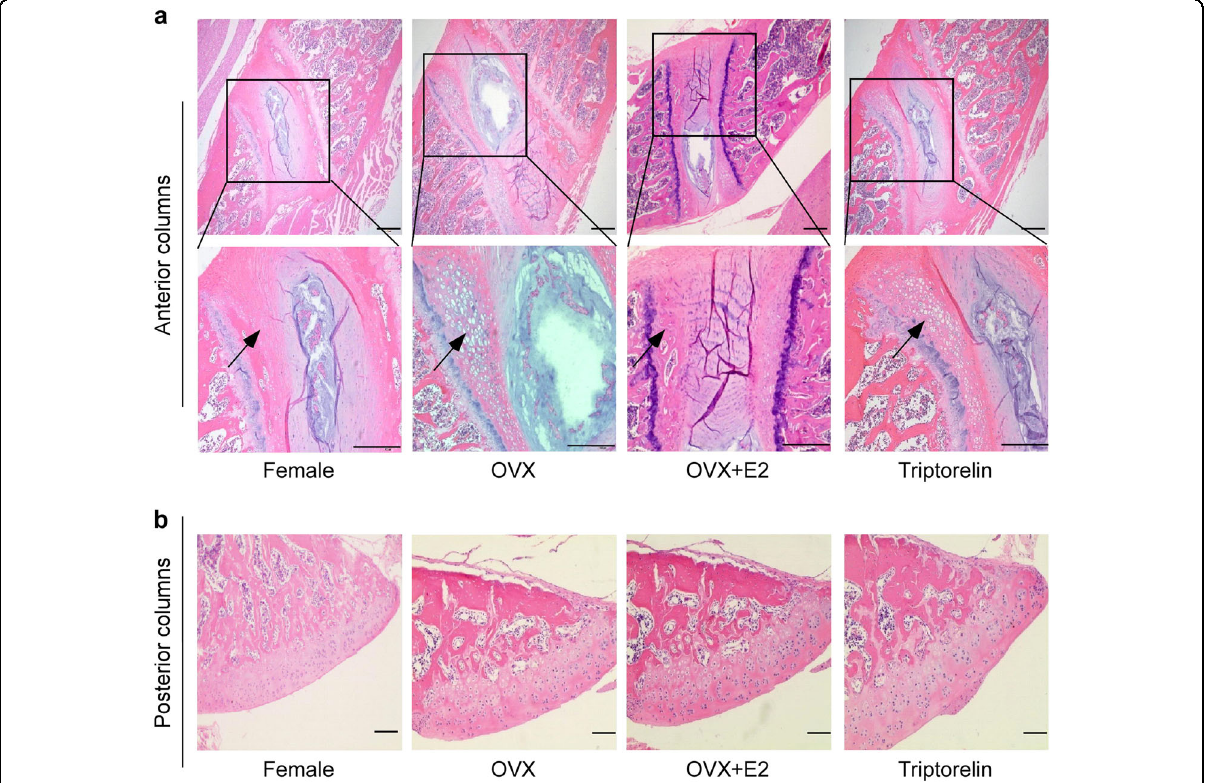
Fig. 3 Histomorphometric analysis of the vertebral growth plate cartilage in the four groups. a H&E staining of anterior columns of the apical vertebra in the four groups of bipedal rats; the lower panel shows higher magni fi cation images of the data shown in the upper panel (×100 and ×200). The cartilage hypertrophic zones (black arrow) were indicated. The height of the hypertrophic zone in the vertebral growth plate was signi fi cantly larger in the OVX and Triptorelin groups than in the female and OVX + E2 groups. The heights of the hypertrophic zone are presented below the images (Table 3). b H&E staining of posterior columns of the apical vertebra in the four groups of bipedal rats (×100). The height of the hypertrophic zone in the vertebral growth plate was signi fi cantly larger in the OVX and Triptorelin groups than in the female and OVX + E2 groups. No difference was observed in the articular cartilage of posterior columns among the four groups. Scale bar, 100 μ m